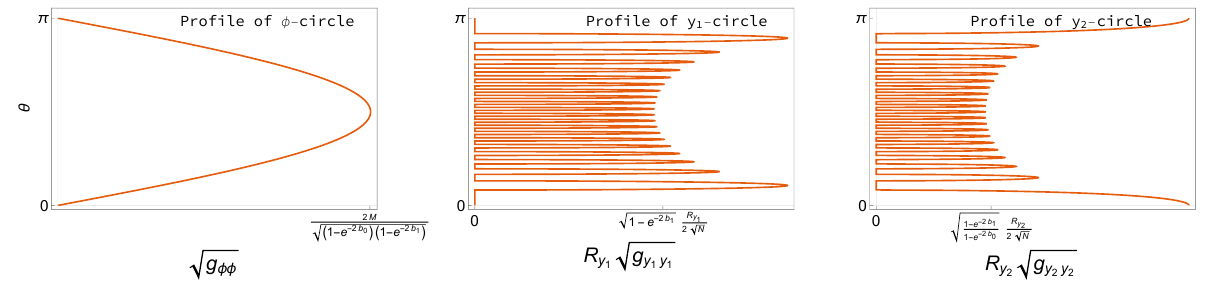
= e R = e R . We have y 2 y 1